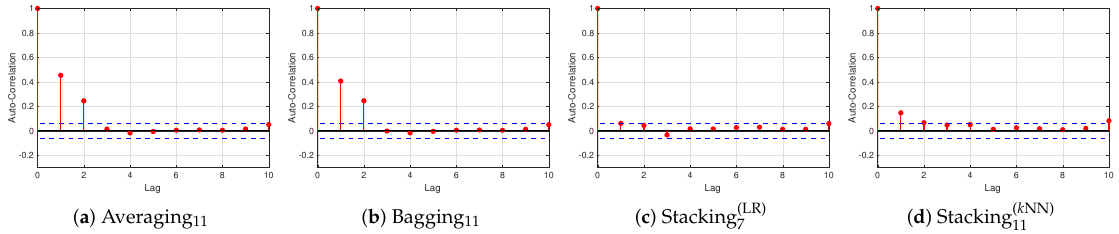
Figure 4. Autocorrelation of residuals for BTC dataset of ensemble models using CNN-LSTM as base learner.